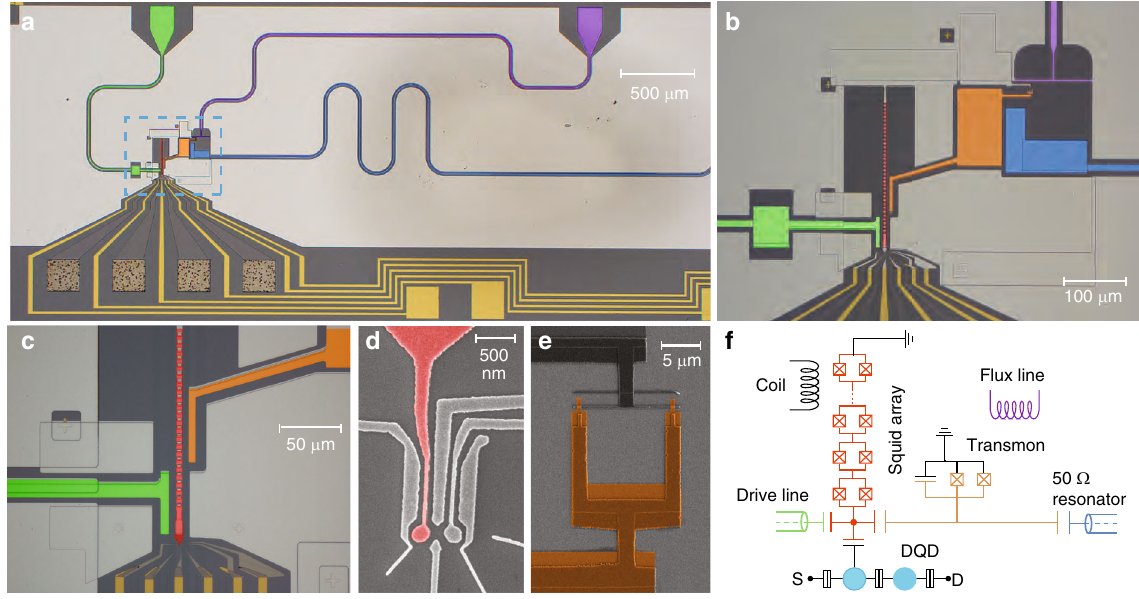
Fig. 1 Sample and simpli fi ed circuit diagram. a False color optical micrograph of the device showing the substrate (dark gray), the Al superconducting structures forming the groud plane (light gray), the DQD Au gate leads (yellow), the SQUID array resonator (red), its microwave feedline (green), the single island transmon (orange), its readout 50 Ω coplanar waveguide resonator (blue), and the fl ux line (purple). b Enlarged view of the sample area enclosed by the blue dashed line in panel ( a ). c Enlarged view of the coupling side of the SQUID array. d Electron micrograph of the DQD showing its electrostatic top gates (Al-light gray) and the plunger gate coupled to the SQUID array (red). e Electron micrograph of the transmon SQUID. f Circuit diagram schematically displaying the DQD [with its source ( S ) and drain ( D ) contact], capacitively coupled to the SQUID array resonator, which in turn is coupled to the transmon. The transmon and the SQUID array are respectively capacitively coupled to a 50 Ω CPW resonator and microwave feedline. Their resonance frequencies can be tuned by using a fl ux line and a coil schematically shown in the circuit diagram. The color code is consistent with the optical